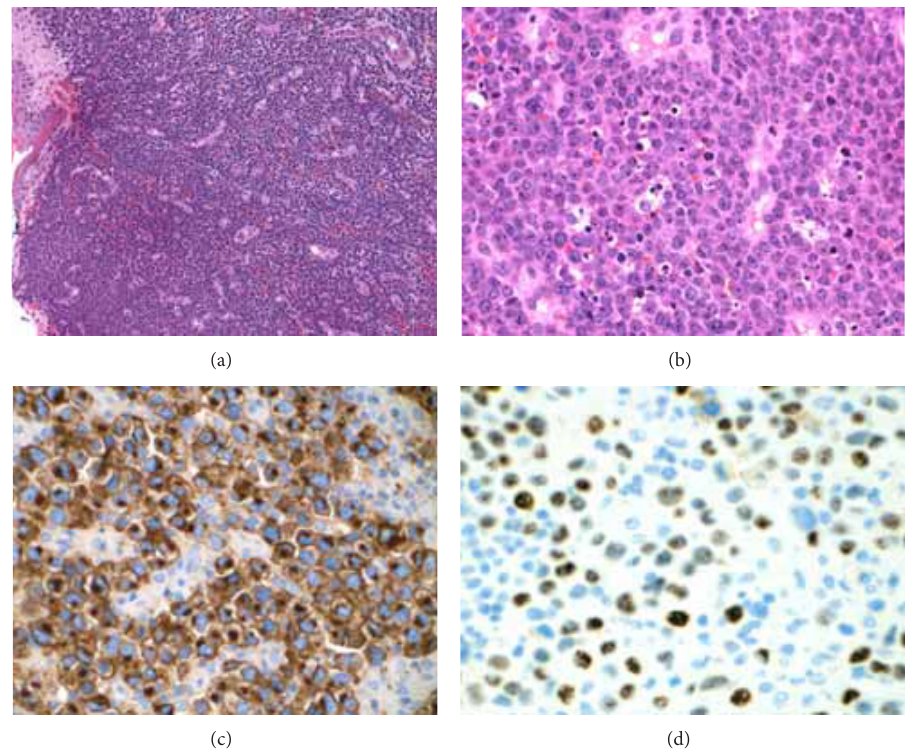
Figure 2: Cutaneous biopsy revealed a diffuse sheet of subepidermal large lymphoma cells with high mitotic rate and occasional tingible body macrophages (a) and (b). Immunohistochemical staining showed expression of CD138 (c) and EBV in situ hybridization (EBER transcript) revealed many of the lymphoma cells infected by EBV (d).